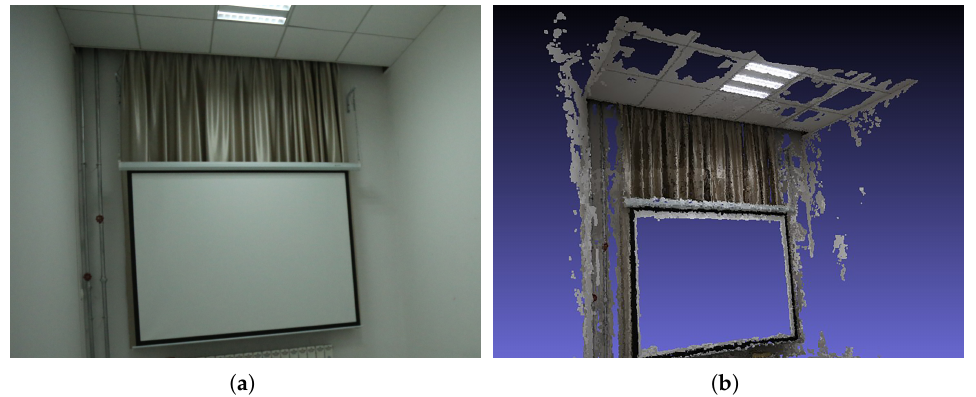
Figure 1. In a weak texture scene, the 3D reconstruction algorithm based on feature points will fail for lack of features. ( a ) A photo of a weak texture scene. ( b ) The point cloud calculated by standard feature matching 3d reconstruction algorithm.